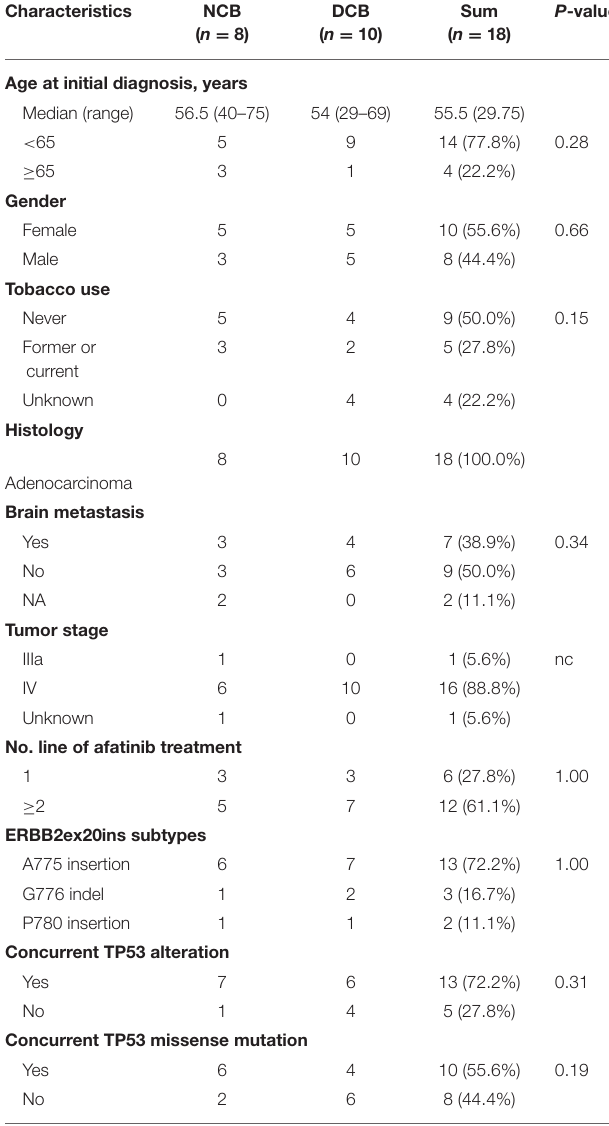
TABLE 2 | Clinical and molecular characteristics of patients treated with afatinib.